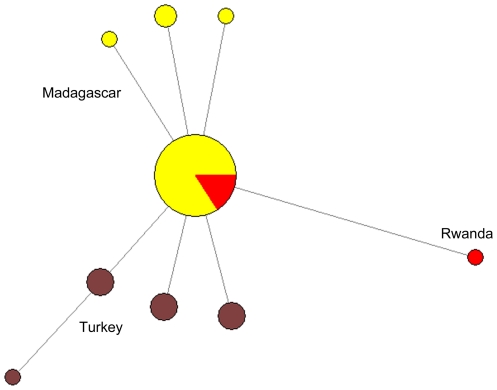
Haplotype network constructed using NETWORK 4.5.0, incorporating 40 Plasmodium vivax mitochondrial genome sequences obtained during this work.Node sizes are proportional to haplotype frequency, and branch lengths are indicative of the number of single nucleotide differencesbetween sequences. Node colours indicate the geographic origin of the isolates and are coded as follows: red = continental Africa (n = 5) (Tanzania (1), Angola (1), Niger (1), Rwanda (1), and Sao Tome (1)) yellow = Madagascar (25), brown = Turkey (10). Haplotype diversities (standard error) are, continental Africa, 0.40 (0.24); Madagascar, 0.29 (0.08); Turkey 0.80 (0.08).